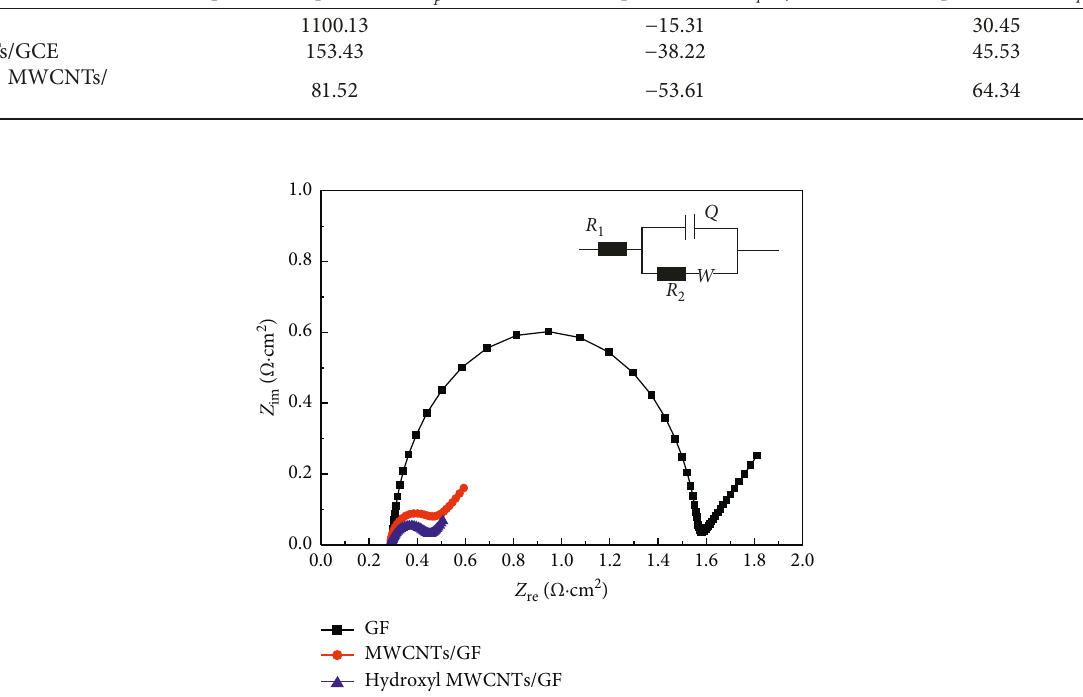
Table 3: Parameters obtained from CV tests with different catalysts at a scan rate of 20mV/s. Samples